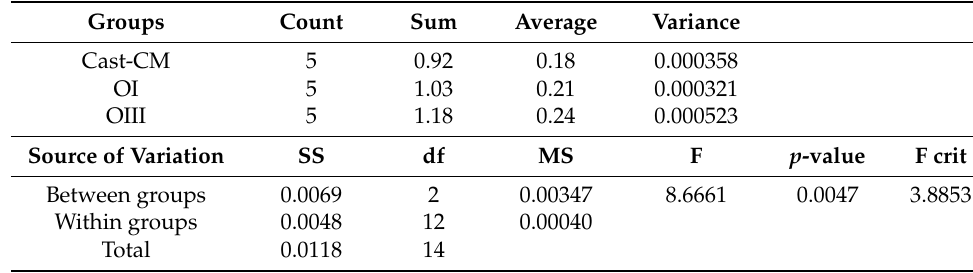
Table 4. One-way ANOVA result of all tested